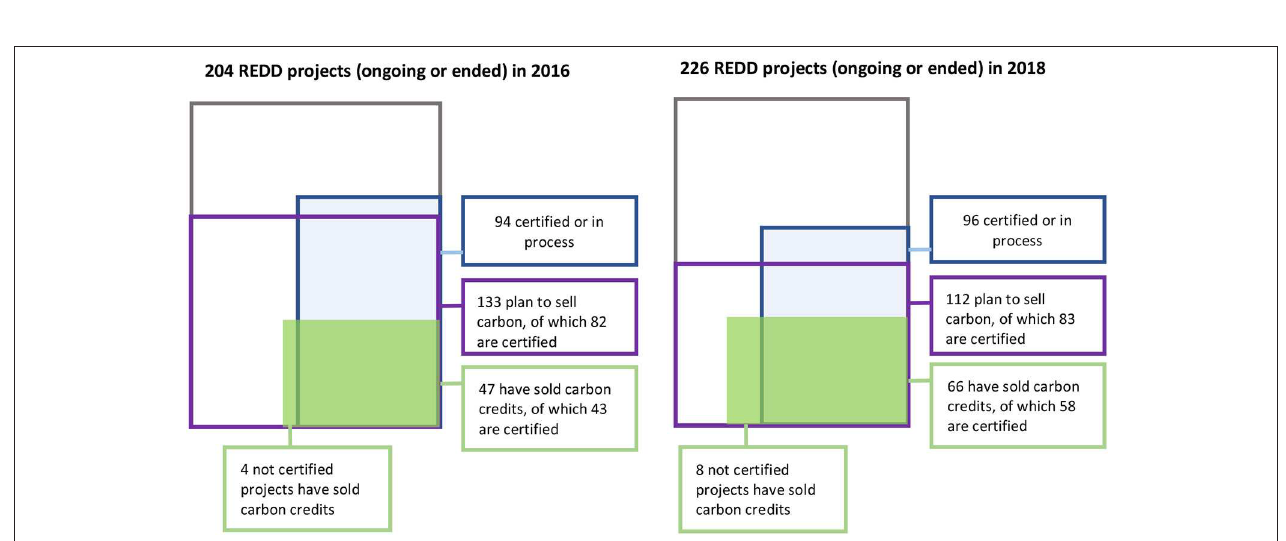
FIGURE 4 | Certification, willingness and ability of REDD projects to sell carbon credits: status in 2016 and 2018 compared. Numbers for each category are symbolized by the area of their relative rectangles, allowing for intersection between the different conditions (e.g., not all projects seeking certification are also seeking carbon sales, while not all projects selling carbon are